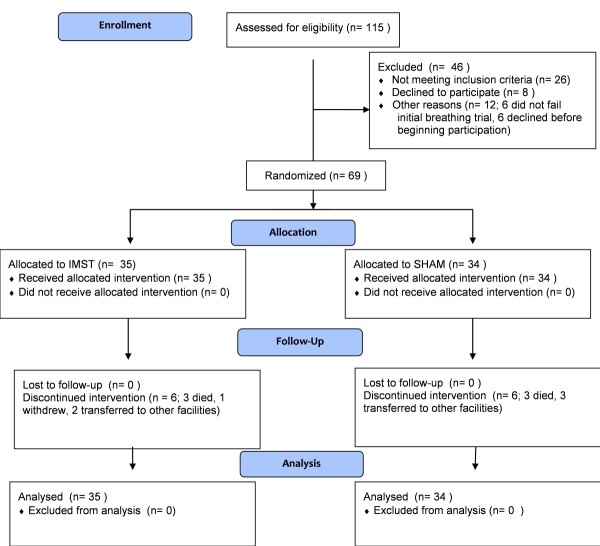
CONSORT diagram.